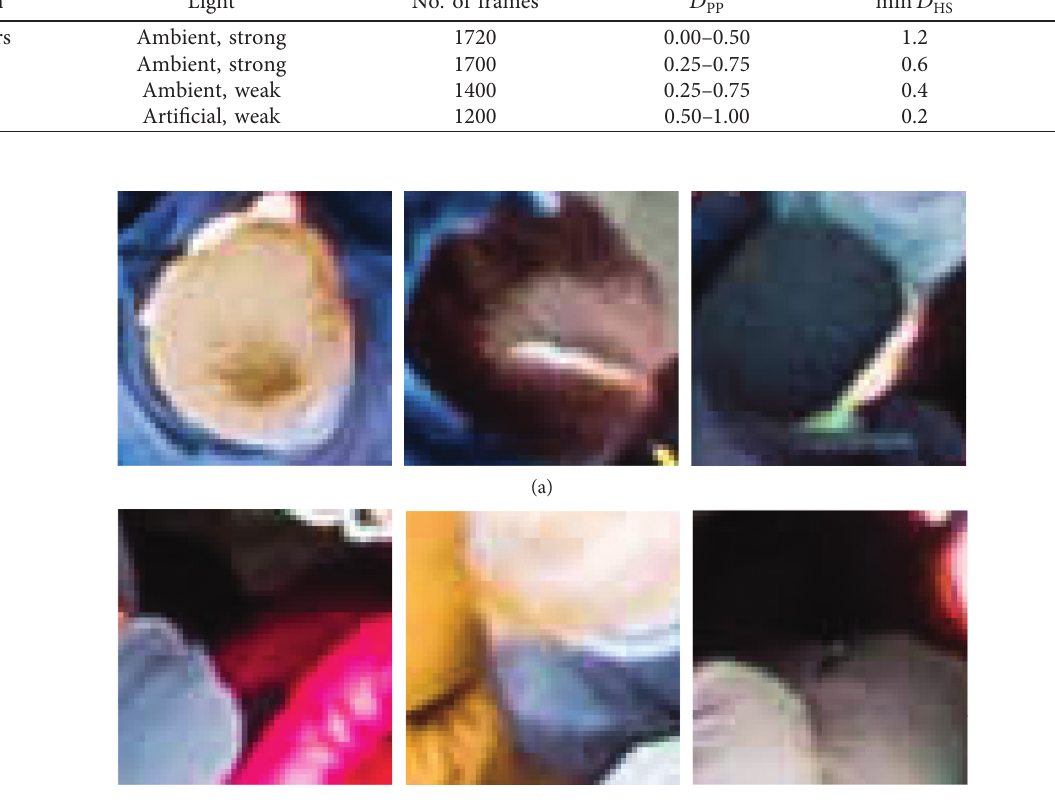
and max D , are specified. HS HS